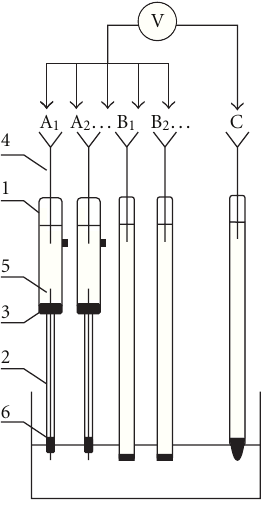
Figure 2: The scheme of the electrochemical cell for the determina- tion of organic electrolytes in multicomponent test solutions: A i is the PD sensor; 1, 2 are plastic encasements; 3, 6 are rubber stoppers; 4 is internal reference electrode; 5 is PSP in K + -type; 7 is 1 M KCl; 8 is the test solution; B i is ISE; C is silver chloride/silver electrode; V is high-resistance